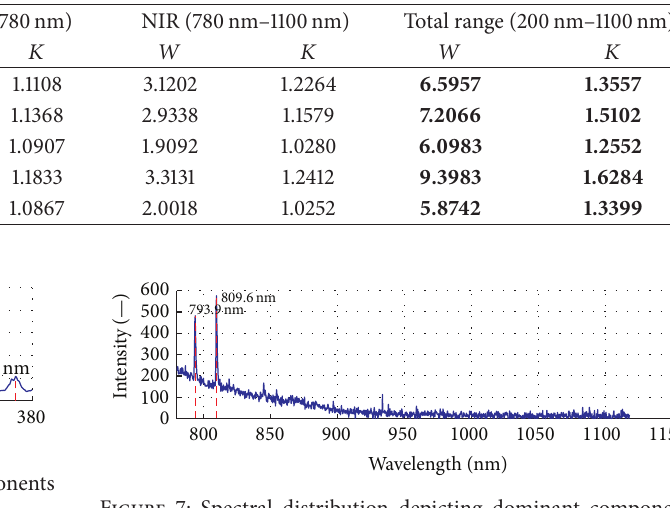
Figure 7: Spectral distribution depicting dominant components within the NIR